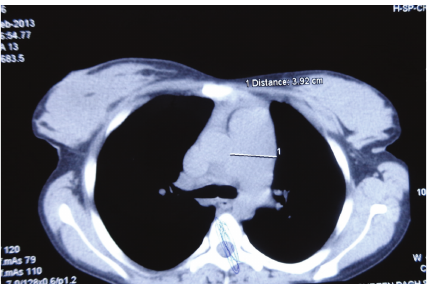
Figure 3: CT chest showing dilated pulmonary artery (marked by 1).